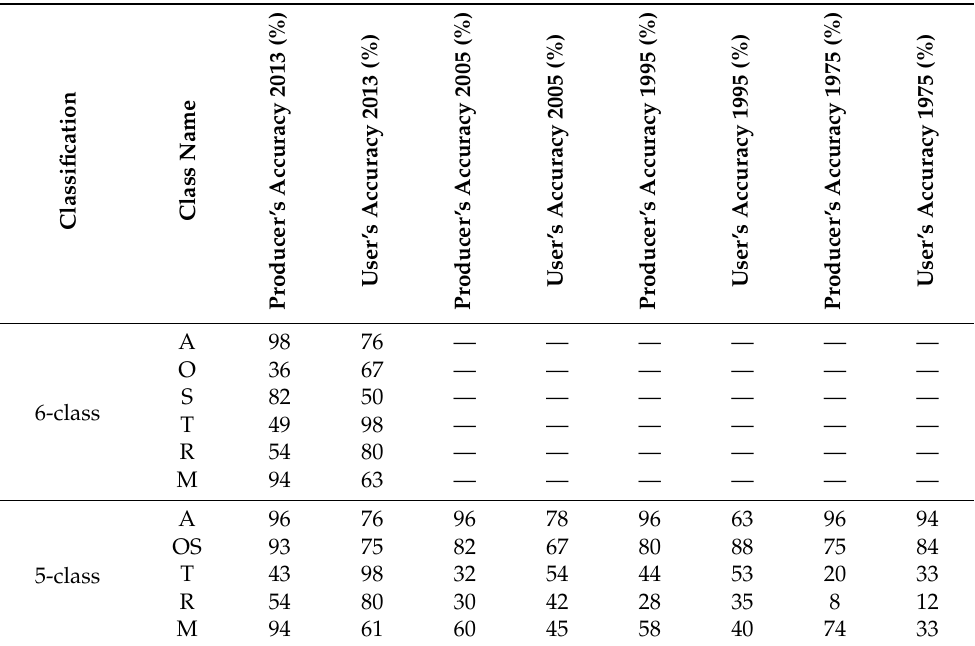
Table 2. Producer’s and User’s accuracies for the initial 6-class 2013 classification and 5-class (Open and Stand Initiation combined as one class) 2013, 2005, 1995, and 1975 classifications. A = Alpine, O = Open, S = Stand Initiation, T = Thin, R = Advanced Regeneration, M = Mature. The Open class had the lowest producer’s accuracy for the 2015 6-class classification, while the Stand Initiation class had the lowest user’s accuracy. When these two classes were combined, their producer’s and user’s accuracies are notably higher. Validation points for 2013, 2005, and 1995 were interpreted from GoogleEarth imagery. Validation points for 1975 were interpreted from digital aerial photographs. Full error matrices of all the final classifications can be seen in Supplementary Material, Tables